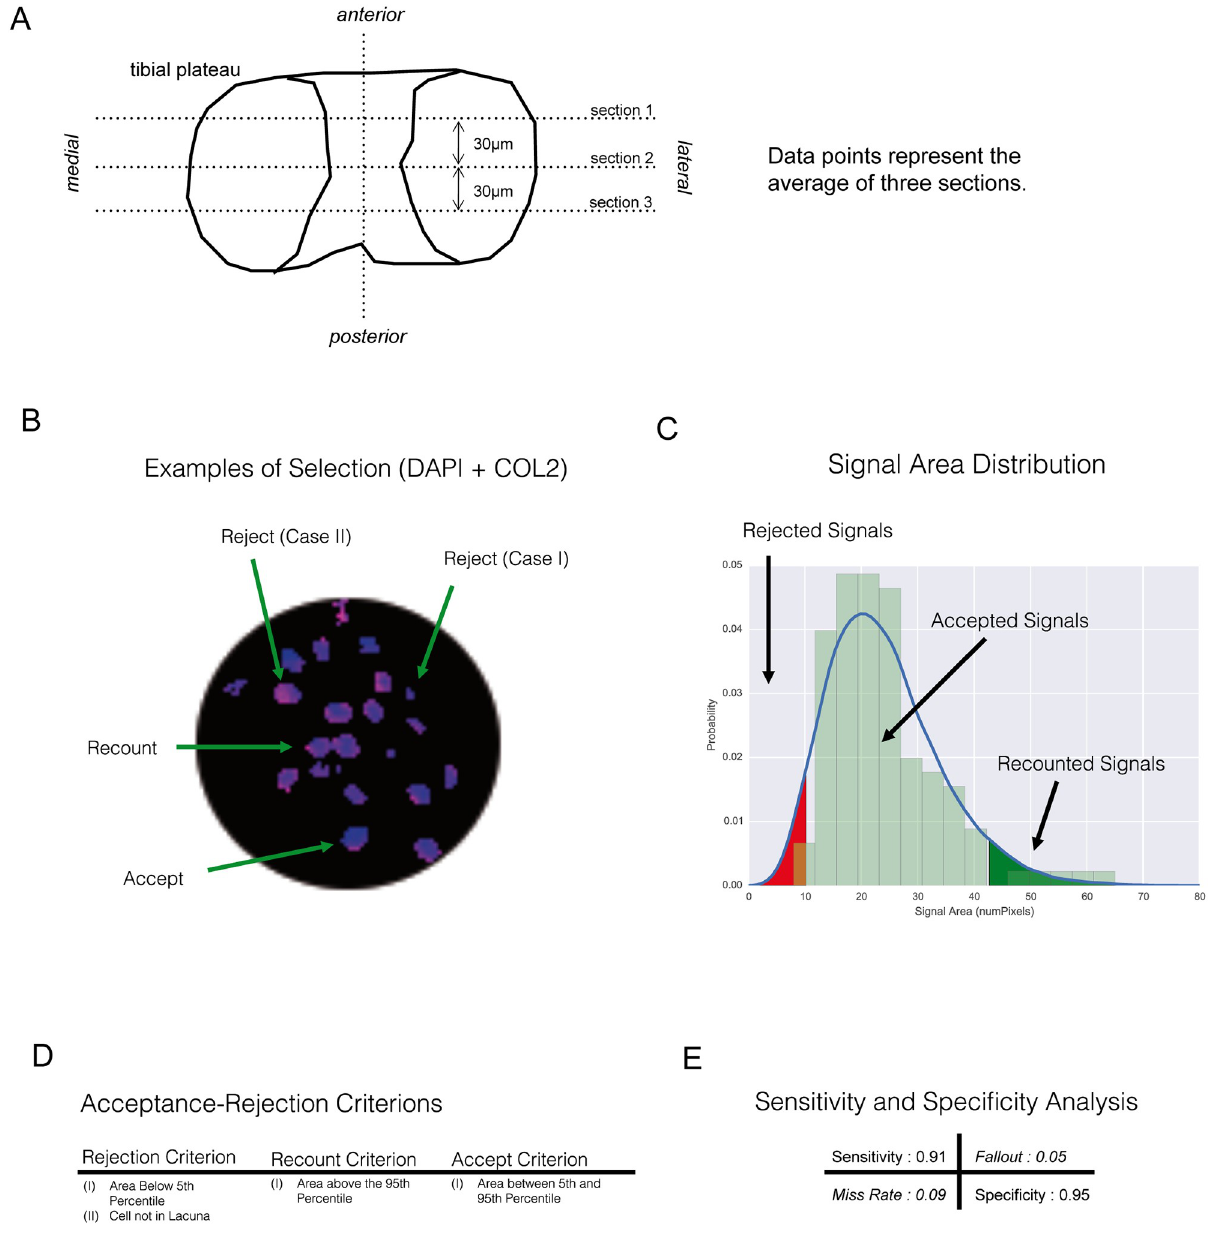
Fig 1. Computer assisted detection of chondrocytes and apoptotic chondrocytes in the histological sections of mouse knee joints. A) Example for the classification of different DAPI signals for the quantification of chondrocytes. B) Area distribution of accepted vs. rejected signals. C) Criteria that define acceptance and rejection of a signal. D) Sensitivity and specificity of the automated detection under the given criteria. E) Histological sectioning and analysis. https://doi.org/10.1371/journal.pone.0213734.g001 products (Col2 3/4Cshort; IBEX Pharmaceuticals). The collagen type I staining was used for discrimination of articular cartilage and osteophytic cartilage structures (not shown). The col- lagen type II staining was used to discriminate the cartilages non-calcified from the calcified layer. Incubation with primary antibodies was followed by incubation with corresponding AlexaFluor-labelled secondary antibodies (Invitrogen) and DAPI staining of cell nuclei.